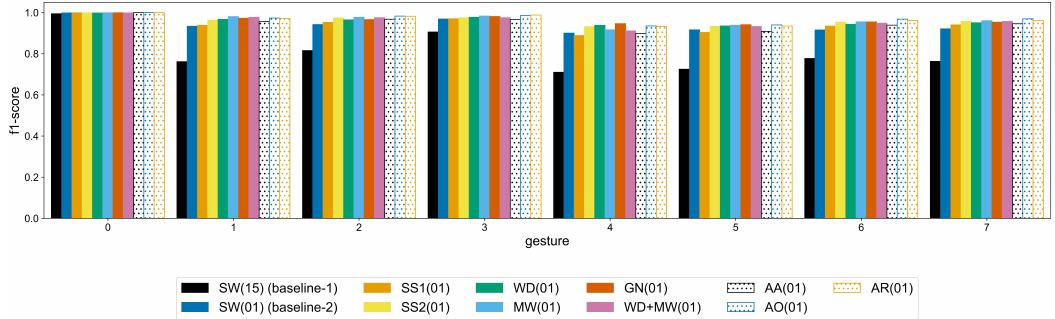
Figure A8. f1 scores of the AtzoriNet* for each gesture of Ninapro-DB1 dataset for τ = 1 and R = 9.